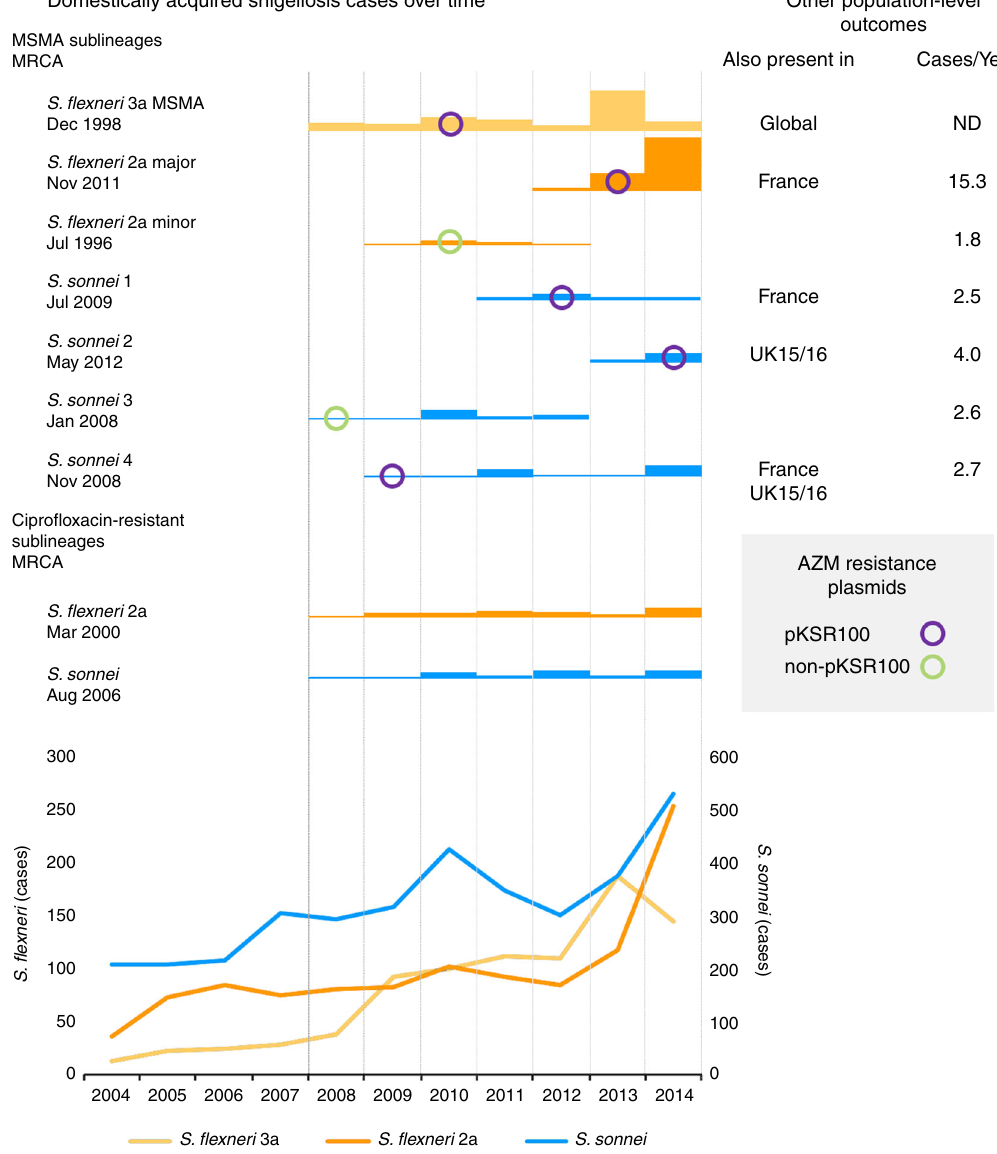
Fig. 2 MSMA sublineage epidemiology and relationship with azithromycin (AZM) resistance determinants. The total number of domestically acquired shigellosis cases is shown in the below graph. Above, the relative number (owing to differences in sampling approach, S. fl exneri 3a is scaled 1:3 relative to the other sublineages, exact numbers available in Supplementary Data 1) of isolates sequenced that belonged to different MSMA and cipro fl oxacin- resistant sublineages is shown by year, along with the time to most recent common ancestor (MRCA). These bar charts are overlaid by a marker indicating the year of fi rst observation, and classi fi cation, of azithromycin-resistance plasmids in the sublineage, according to the inlaid key. For MSMA sublineages, other population-level outcomes, as discussed in the text, are also shown to the right, including other regions and times where the sublineage was detected (also present in) and the number of cases detected per year (cases/year) attributable to that